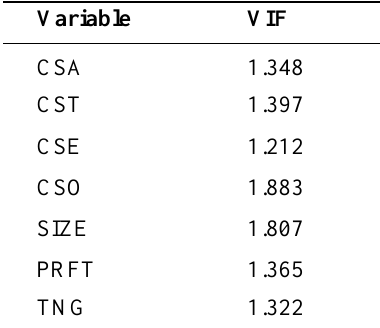
Table 3: Variance Inflation